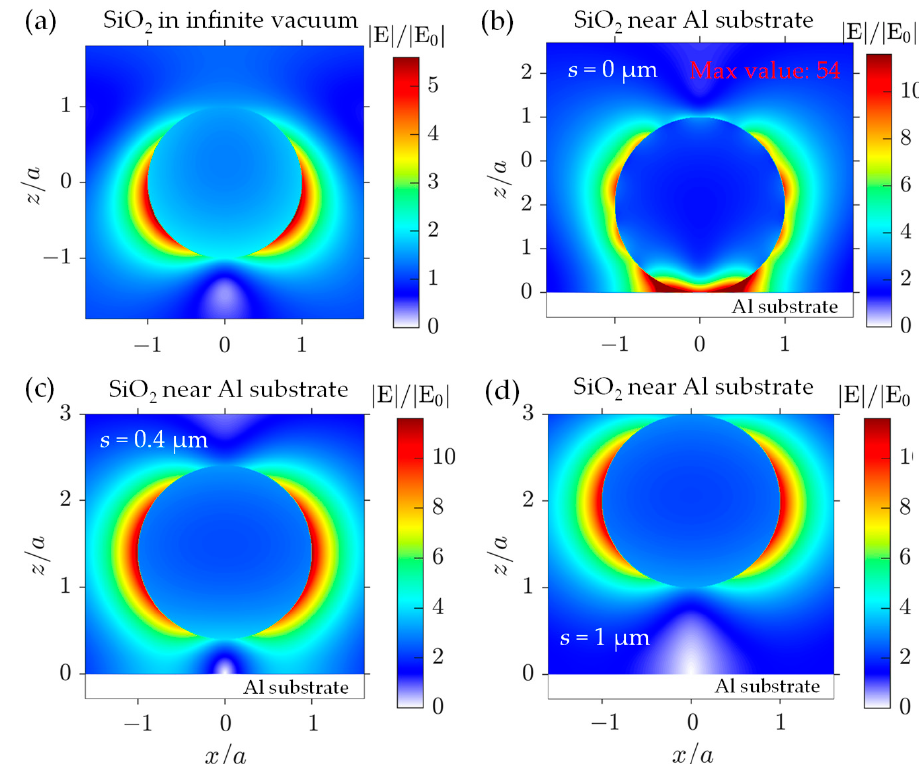
Figure 5. Normalized electric fi elds |E|/|E 0 | in xz -plane of a SiO 2 particle with a = 1 µm, where |E 0 | is the amplitude of the incident electric fi eld. The incident wavelength is selected at the resonance position of λ = 8.9 µm. ( a ) The electric fi elds of the SiO 2 sphere in the free space. ( b – d ) The electric fi elds of the SiO 2 sphere above Al substrate with the varied distances of ( b ) s = 0 µm, ( c ) s = 0.4 µm, and ( d ) s = 1 µm. It should be noted that the maximum number of normalized fi elds in ( b ) is 54.